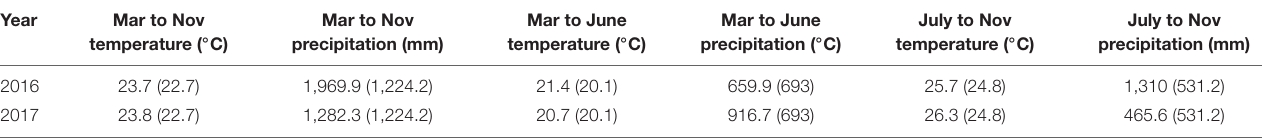
TABLE 1 | Climatic characteristics were observed from the monitoring site from